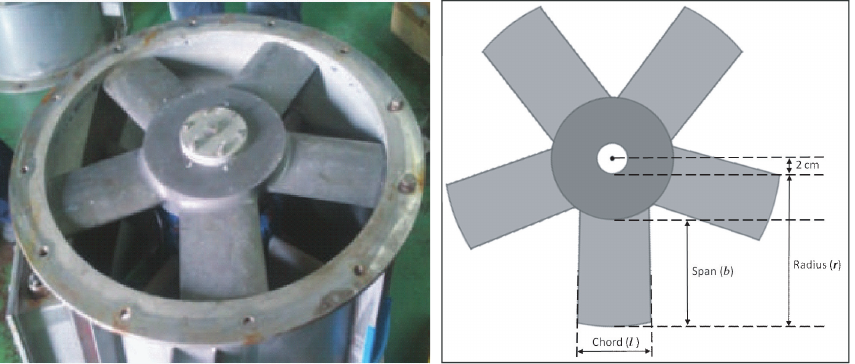
Figure 4. Wells turbine of the NEREIDA OWC